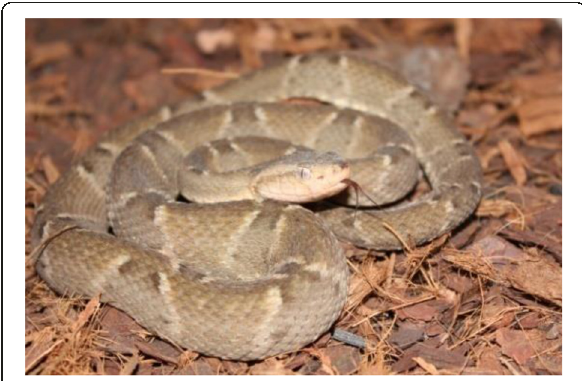
Table 1 Laboratory tests conducted at the Hospital João de